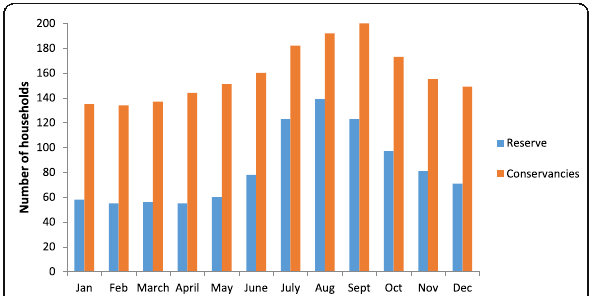
Figure 6 Monthly calendar of the use of the MMNR and conservancies (Olare Motorogi Conservancy, Mara North Conservancy and Naboisho Conservancy combined) by livestock herders in Koyiaki during 2009 to 2010 ( n =